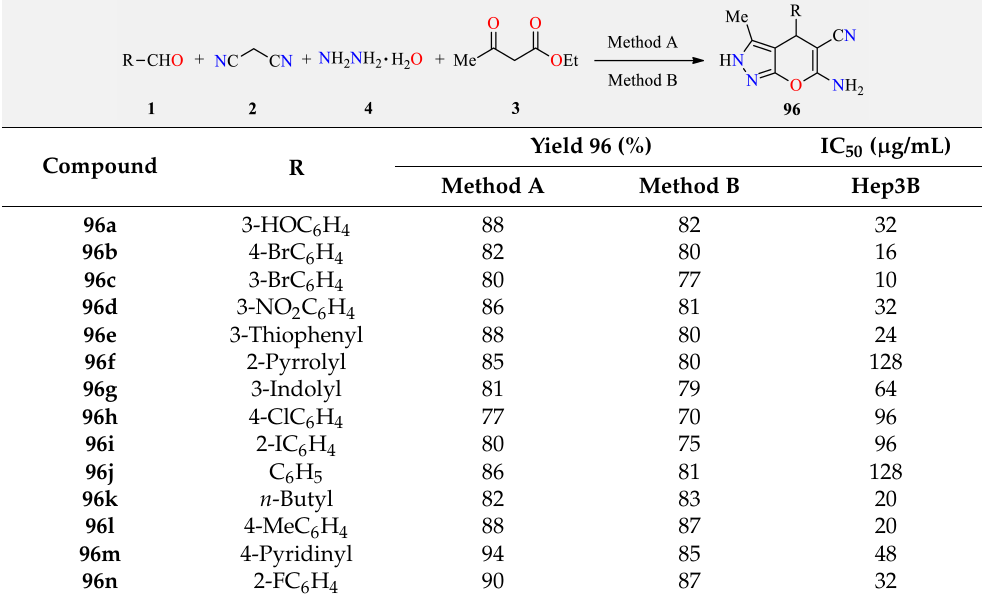
Table 28. Four-component synthesis and anticancer activity of pyranopyrazole derivatives 96 .